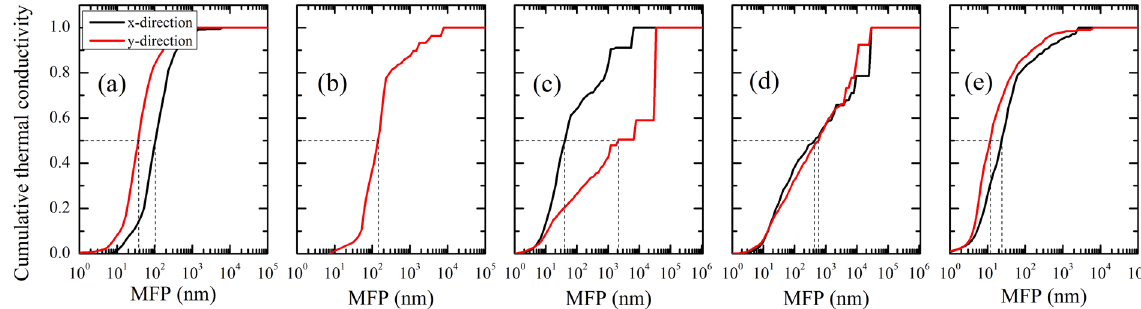
Figure 5. The normalized accumulative thermal conductivity at room temperature as a function of cutoff phonon MFP for: ( a ) α -phosphorene, ( b ) β -phosphorene, ( c ) γ -phosphorene, ( d ) δ -phosphorene, and ( e ) ζ -phosphorene. The dashed line denotes the MFP value corresponding to 50% κ